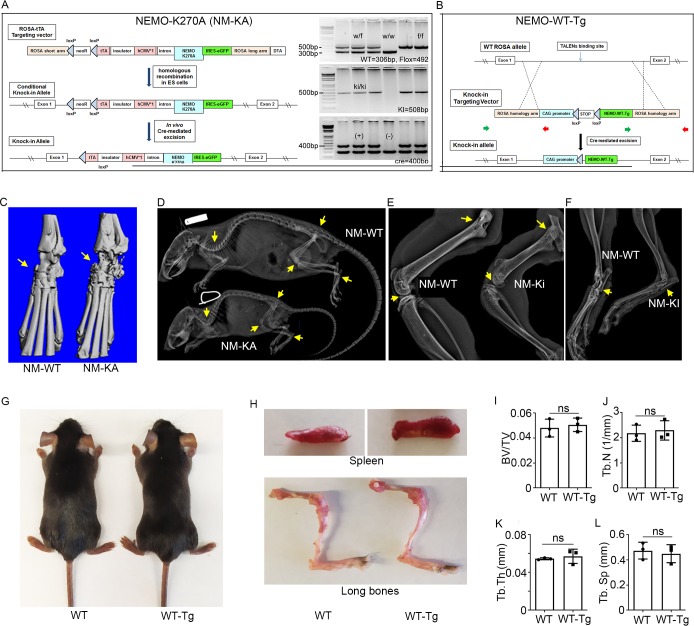
Generation of NEMO transgenic mice.Schematic diagram showing generation of conditional (A) NEMO-K270A-KI (NM-KA) and (B) NEMO-WT-Tg (NM-WT-Tg) mice (6 weeks old). (C) MicroCT images of paw and ankle joint showing osteolysis in NM-KA mice (arrow). X-ray images of NM-WT and NM-KA mice showing significant bone loss and deformities in (D) whole body (E) Knee joint (F) ankle and paw (arrow pointing towards osteolysis and deformed bones). (G) Whole body images of NM-WT and NM-WT-Tg mice (6 weeks old). (H) Photomicrograph of spleen and bone from NM-WT and NM-WT-Tg mice. MicroCT analysis showing quantification of (I) Bone volume/total volume (BV/TV), (J) Trabecular number (Tb.N), (K) Trabecular thickness (Tb.Th) and (L) Trabecular separation, between NM-WT and NM-WT-Tg mice (n = 3).